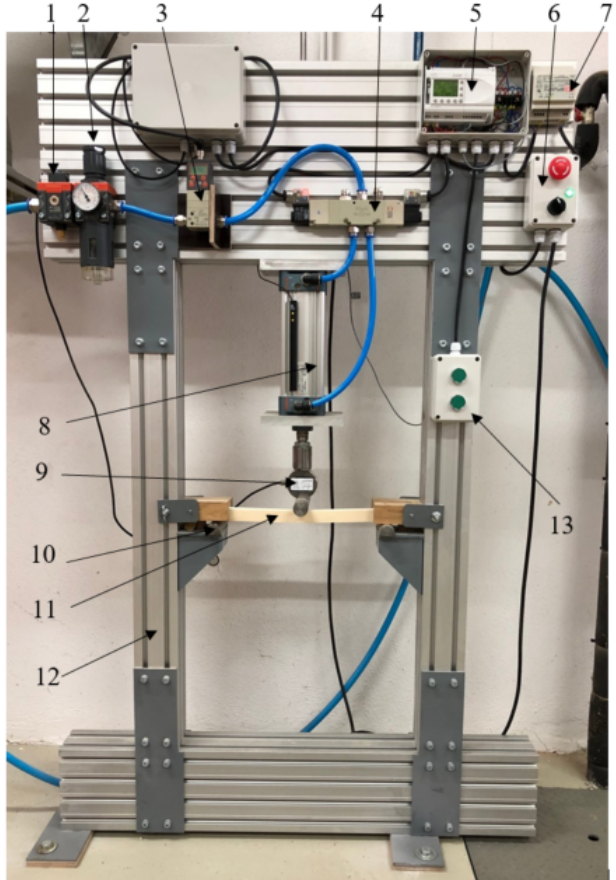
Figure 2. Main fatigue test rig’s components: 1. Cut-off switch, 2. Air preparation unit, 3. Digital air regulator, 4. Two valves, 5. Programmable logic controller, 6. Main power switch (emergency Stop), 7. Power supply 8. Pneumatic cylinder, 9. Load cell, 10. Cylindrical support, 11. Specimen, 12.